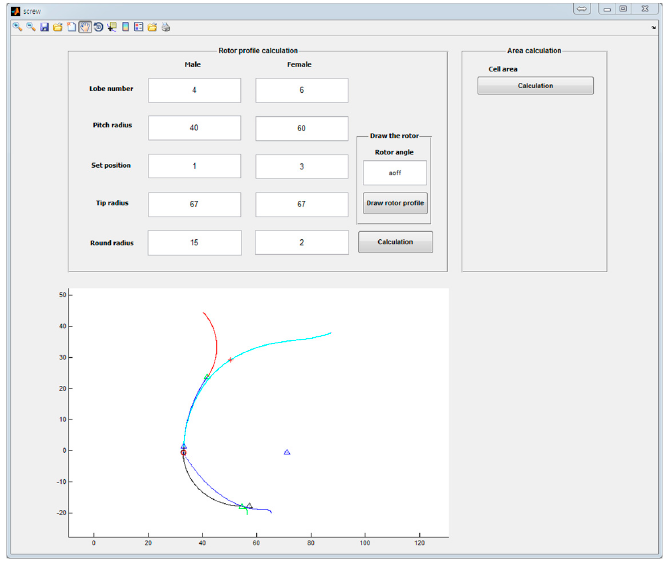
Figure 3. MATLAB-based screw rotor profile design program.